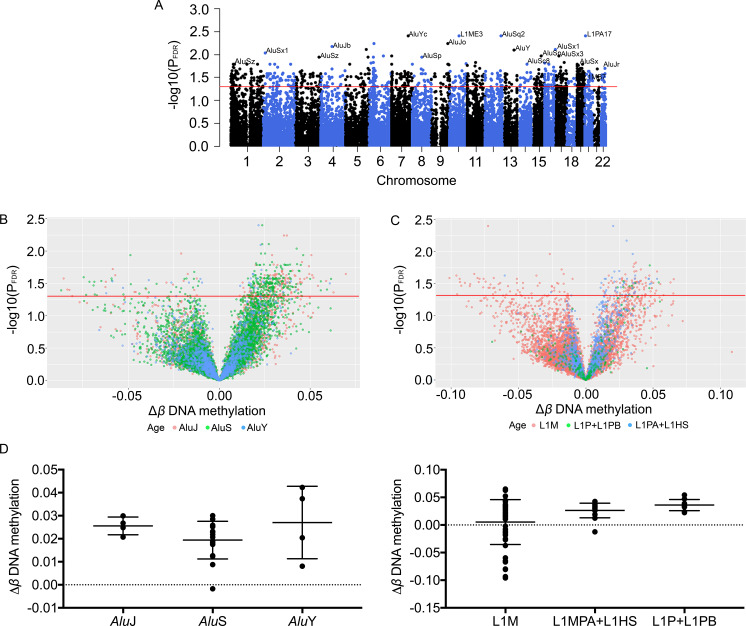
Differentially methylated positions in pre-symptomatic dementia (PSD) at 18-month follow-up.(A) Manhattan plot of retrotransposon loci displaying significant changes in DNA methylation between type 2 diabetes patients with and without PSD at follow-up. B-C) Volcano plots of changes in retrotransposon methylation (Δβ) in PSD by evolutionary age of Alu (B) and LINE-1 (C) elements. D) Changes in DNA methylation (Δβ) by evolutionary age of LINE-1 and Alu elements. The Red line represents PFDR = 0.05.